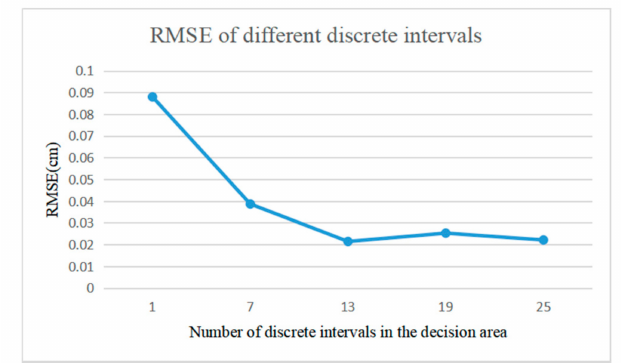
Figure 8. RMSE in the decision area corresponding to di ff erent discrete intervals.